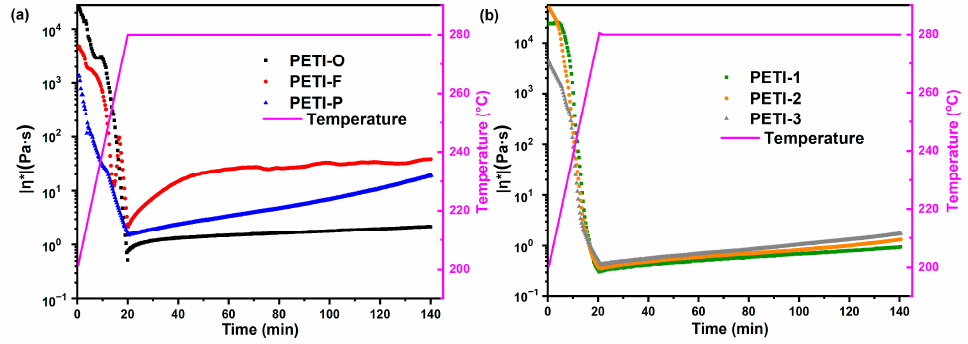
Figure 5. Complex melt viscosities of the ( a ) PETI-O, PETI-F, PETI-P and ( b ) PETI-1, PETI-2, PETI-3